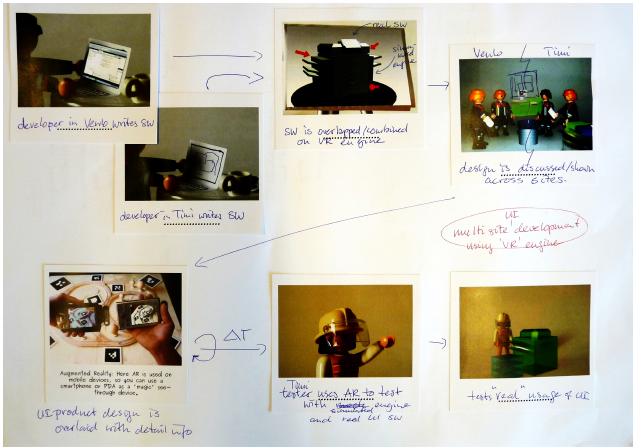
One of the individual storyboards created during the workshop. The storyboards visualise the designer’s ideas about how to apply VR in the product development